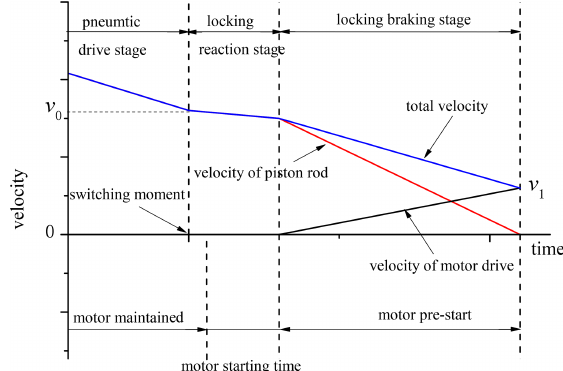
Figure 20. Velocity control principle in the relay and run